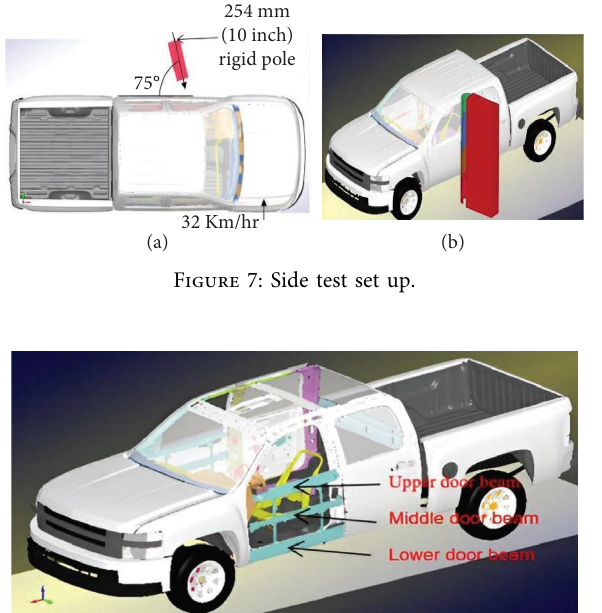
Figure 8: Modifed